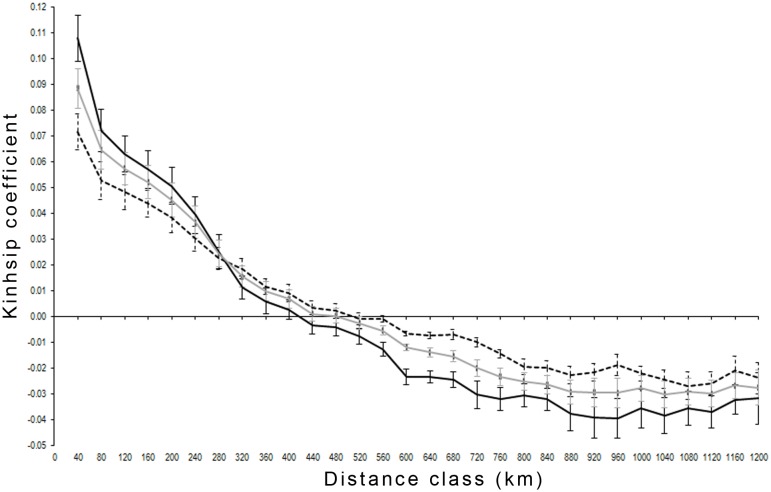
Loiselle kinship coefficient for brown bears in Scandinavia.One distance class is 40 km, solid black line = females; broken black lines = males; solid gray lines = females and males combined; 95% confidence intervals are displayed accordingly.